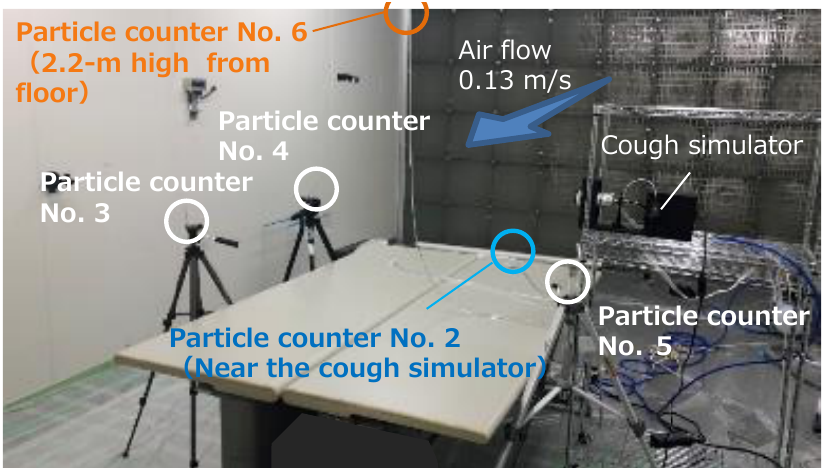
Figure 2. Experimental view of the tabletop partition experiment.